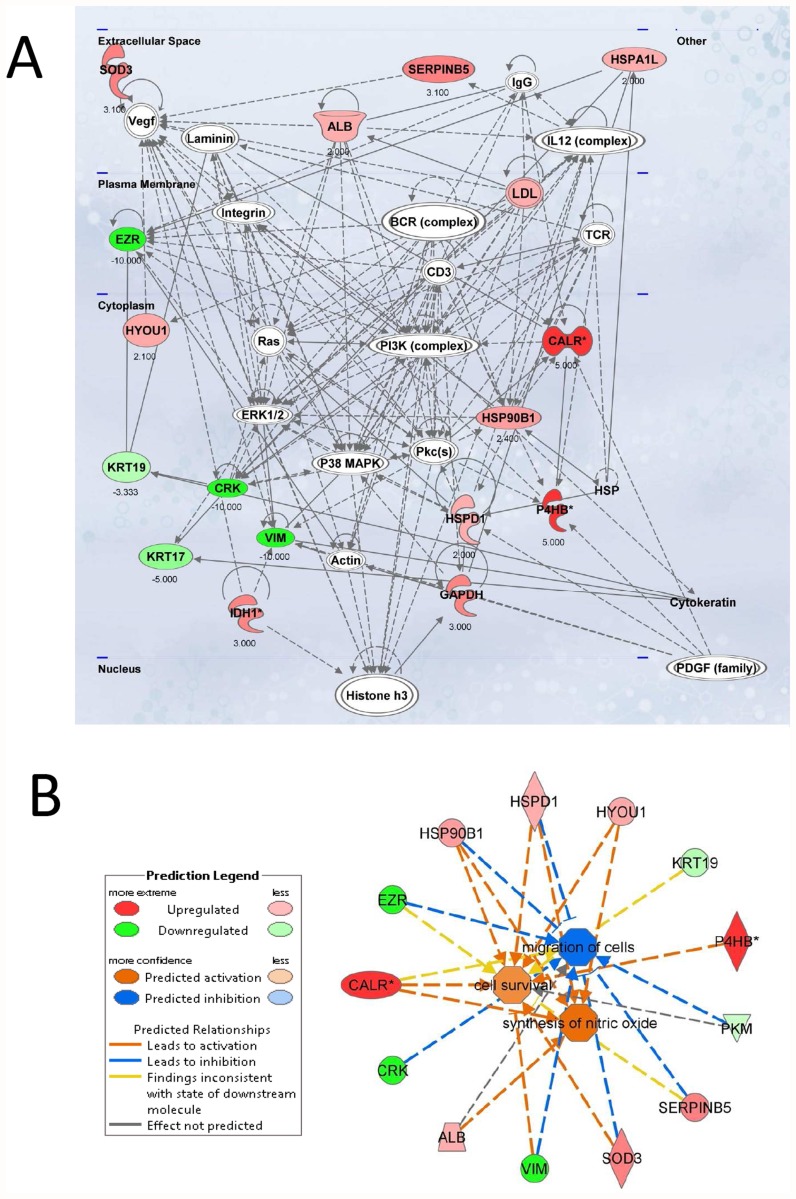
Top network functions affected in the EMT process of cholangiocarcinoma cells.Two relevant networks were generated from EMT-modulated proteins according to the Ingenuity Pathway Knowledge Criteria. A. Cellular compromise, cellular function and maintenance (score = 45). Red, upregulated proteins; green, significantly downregulated proteins; white, proteins known to be in the network but not identified in this study. The color depth indicates the magnitude of the change in protein expression levels. The shape is indicative of the molecular class (i.e protein family). Lines connecting the molecules indicate molecular relationships. Dashed lines indicate indirect interactions, and solid lines indicate direct interactions. The arrow styles indicate specific molecular relationships and the directionality of the interaction. B. Network build up from the three most significant bio-functions (activation Z score >2 or <2): cell survival, synthesis of nitric oxide and migration of cells. The symbols nomenclature is shown in the lower panel.